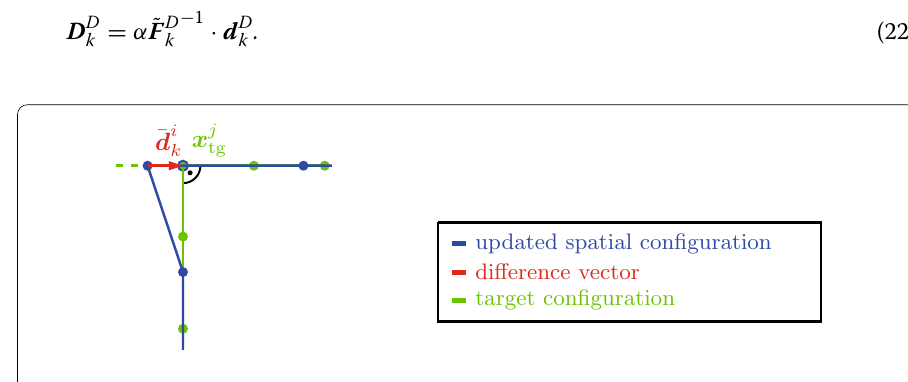
Fig. 8 A 90 ◦ -corner case for computing a difference vector ˜ d i